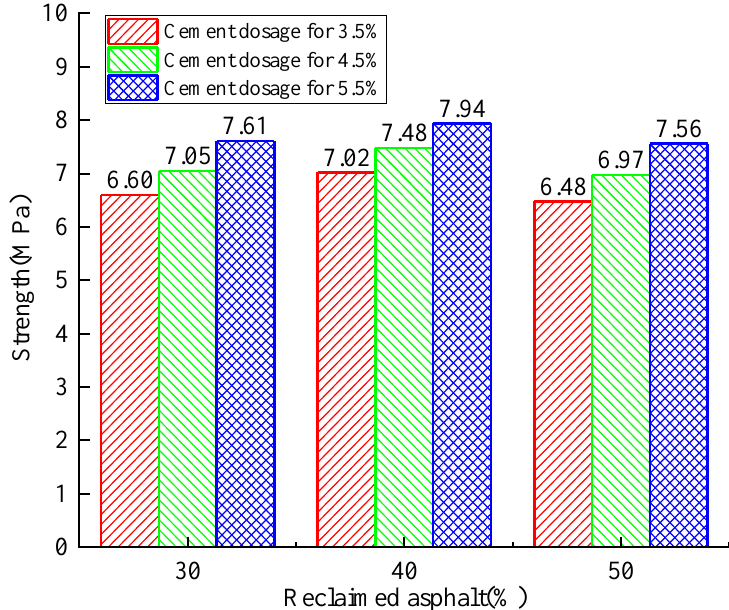
Figure 10. Analysis of the 90-day axial compressive-strength test with variation of cement dosage and RAP. and RAP.